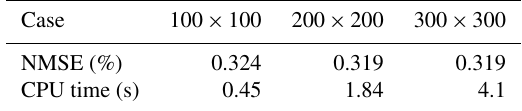
Table 1. Performance for each case with p = 1.